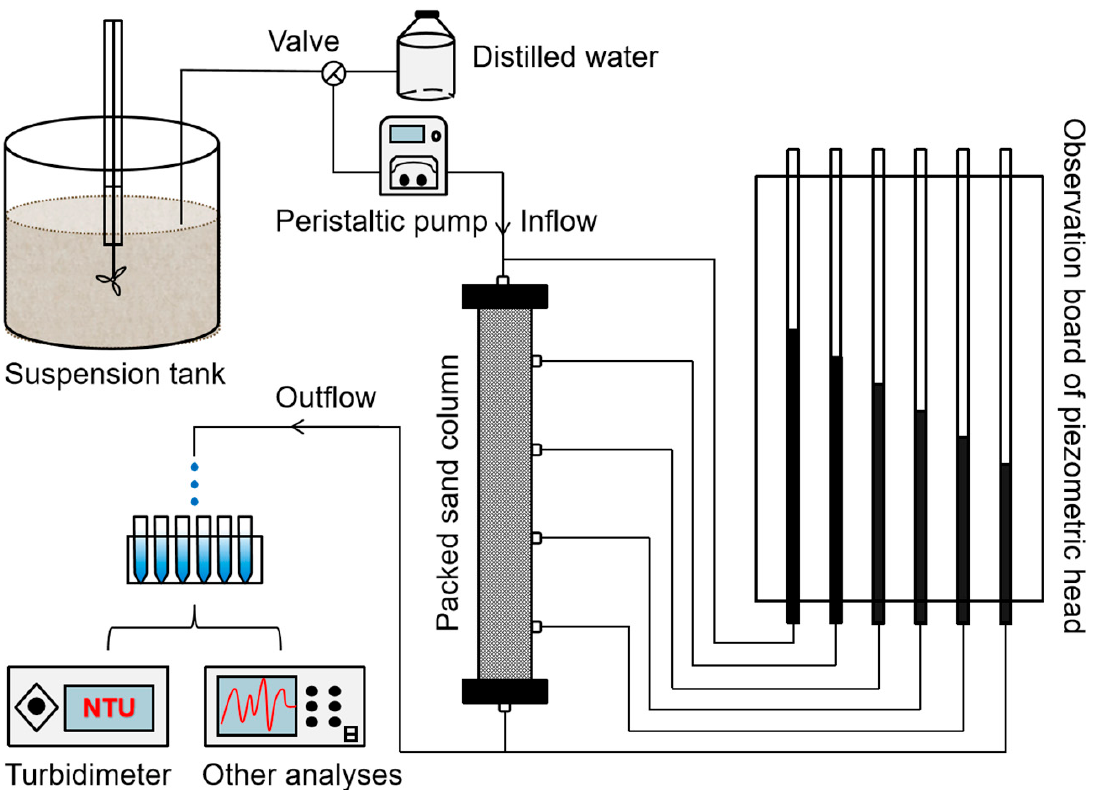
Figure 2. Schematic of setup for column experiments.